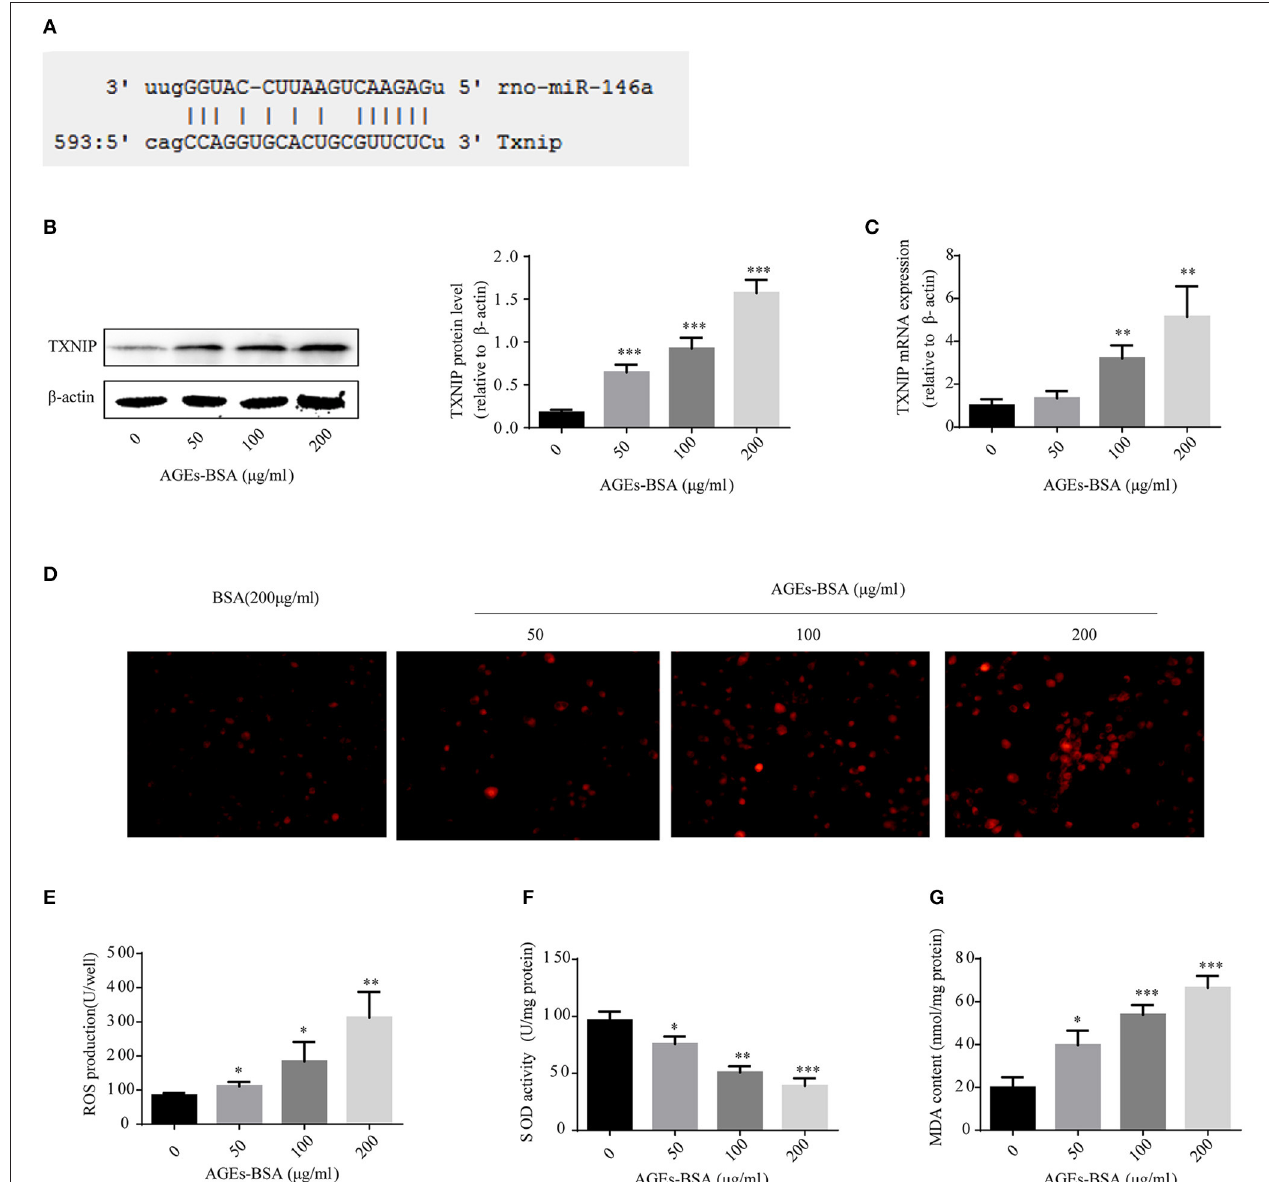
FIGURE 8 | Effects of AGEs-BSA on TXNIP expression and ROS levels. (A) The predicted miR-146a binding sites within 3 ′ UTR of TXNIP. (B,C) TXNIP protein and mRNA levels determined by Western blotting and qPCR. (D) ROS concentrations and fluorescence micrographs of ROS levels. (E) ROS production. (F) SOD